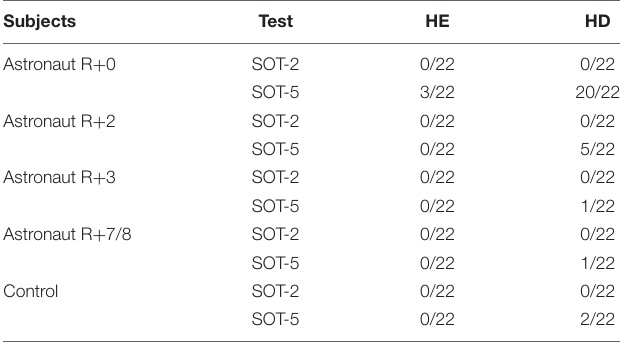
TABLE 1 | Number of falls across the head (HE and HD) and support-surface (SOT-2 and SOT-5) postural test conditions in 11 astronaut subjects during R + 0, R + 2, R + 3, and R + 7/8 sessions and in 11 control subjects during the R + 0